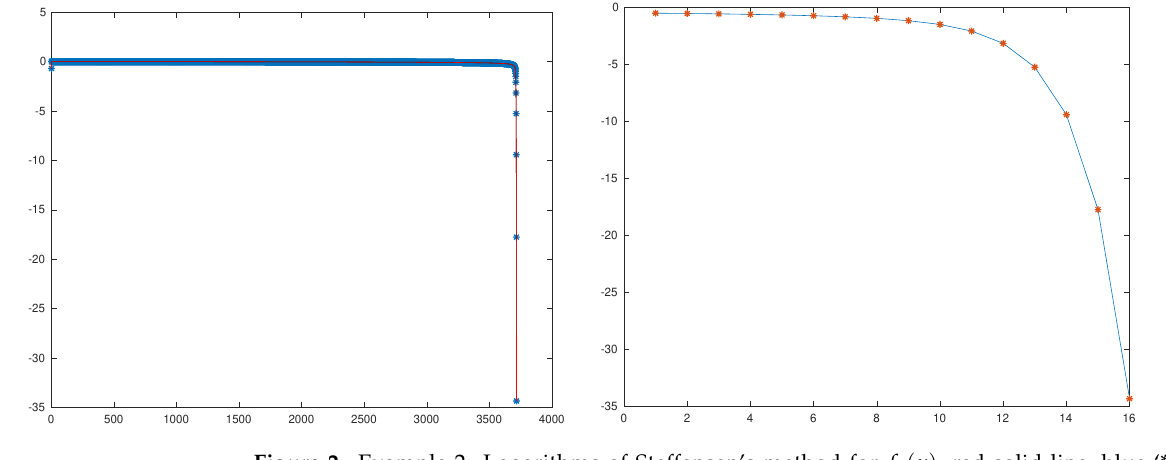
Figure 2. Example 2: Logarithms of Steffensen’s method for f 2 ( x ) , red solid line, blue ‘*’ ( left ); iterations from 3700 to 3716, blue solid line, red ‘*’ ( right